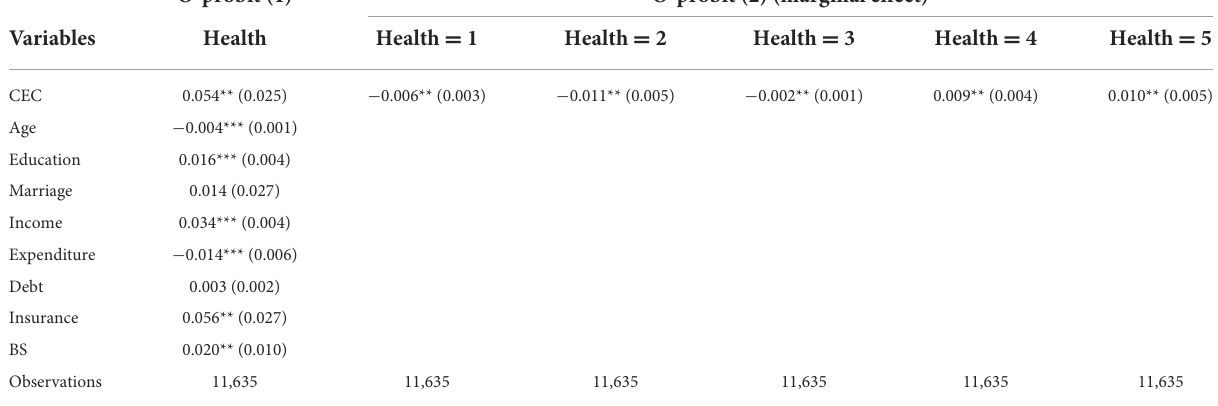
TABLE 3 The regression results of CEC and health.